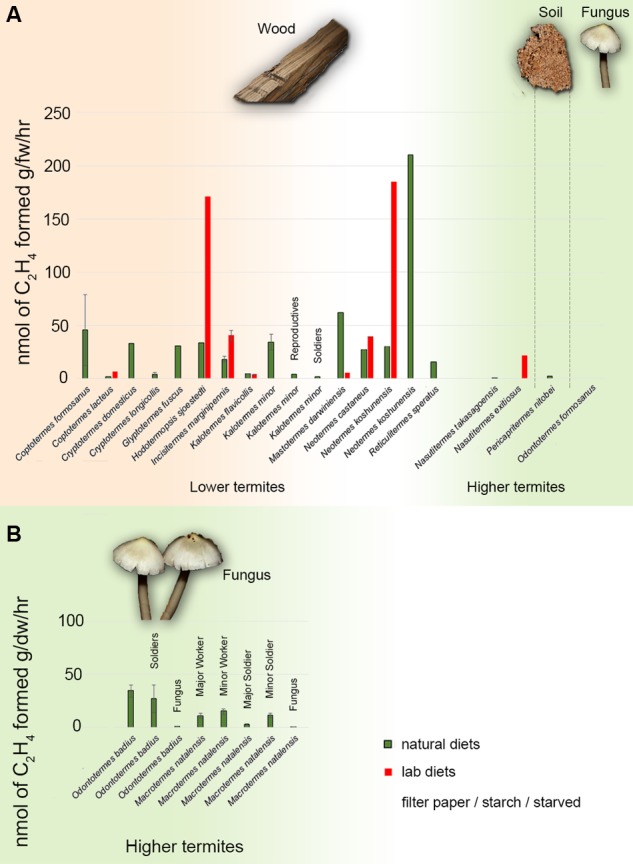
ARA fixation rates in termites. (A) Summary of diazotrophic fixation rates in investigated termite species from the literature. The fixation rates are expressed as nmol C2H4 per gram fresh weight per hour determined through ARA. The data presented are from Benemann (1973), French et al. (1976), Noda et al. (1999), Ohkuma et al. (1999, 2015) and Desai and Brune (2012). (B) ARA fixation rates measurements of fungus-growing termites from the present study; bars represent the mean of six replicates (three per colony for two colonies). Fixation rates are expressed as nmol C2H4 per gram dry weight per hour. Bar colors indicate whether the termite were fed on natural (green) or artificial (red) diets during ARA measurements. Each termite species’ natural diet is presented on top of the histograms. All measurements were performed on termite workers except where indicated above the bars. Error bars showing SE are presented, where available.